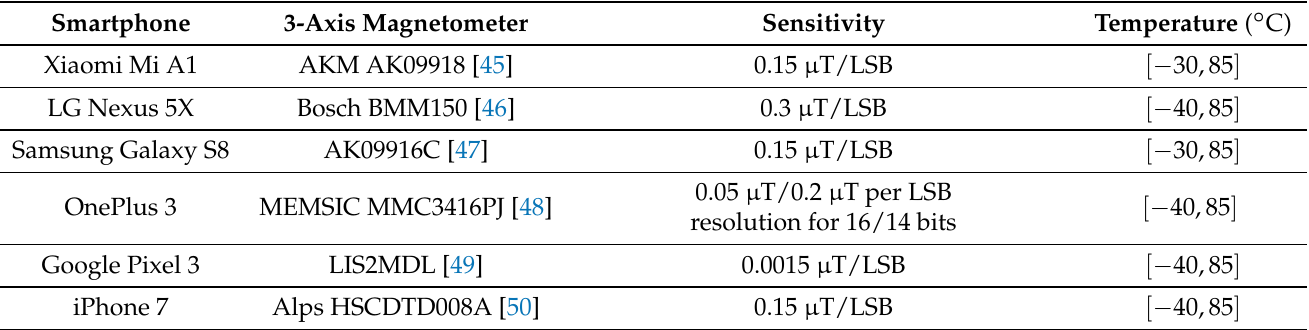
Table 1. Magnetometers of different